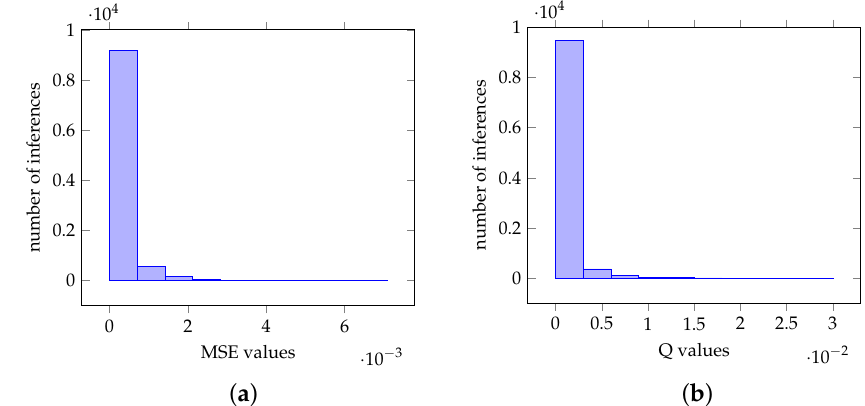
Figure 9. Values obtained from imagenet image inceptionV3 net classification for 1000 classes. ( a ) Histogram of the MSE values. ( b ) Histogram of the Q (cid:48)